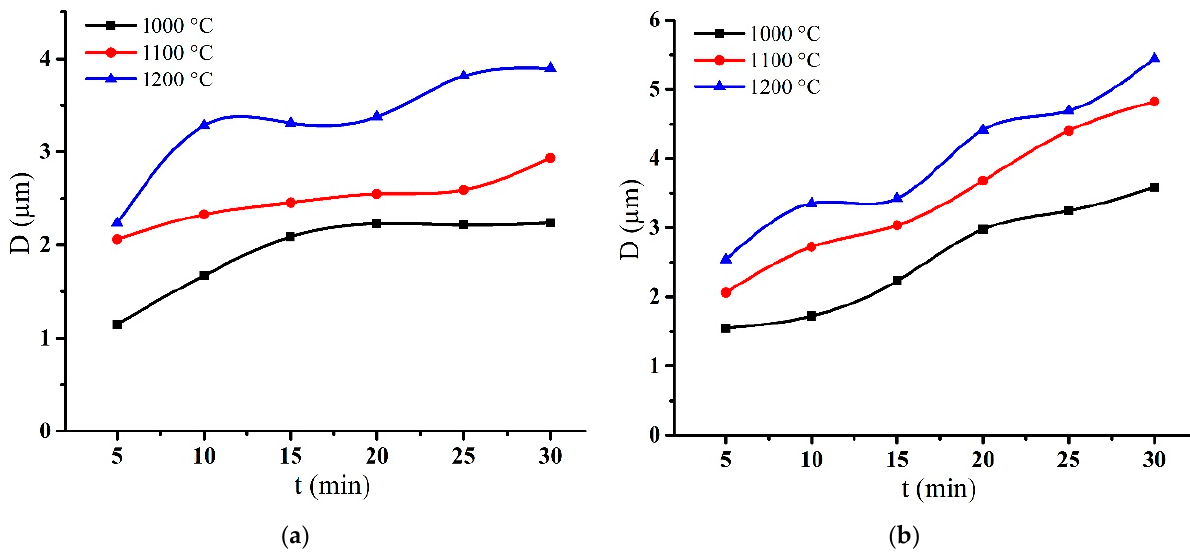
Figure 4. The dependence of the average Feret diameter of iron grains on the reduction temperature and time for the RM roasting without additives ( a ) and with 13.65% Na 2 SO 4 ( b ).